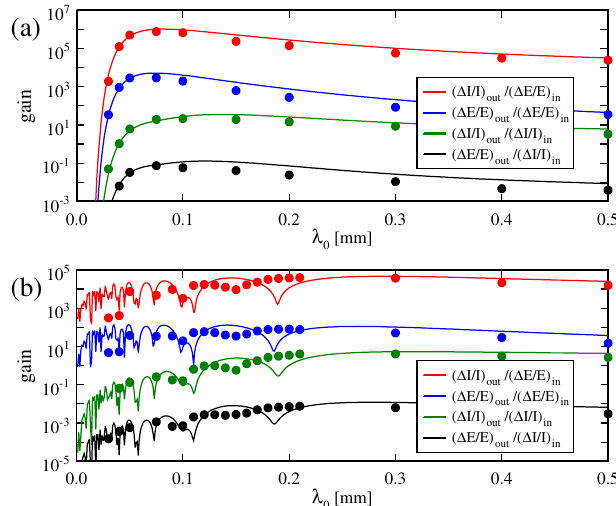
FIG. 10. (Color) Curves show the analytical microbunching gain between the entrance of the BC1 chicane at 215 MeVand the exit of the L2 linac at 1.7 GeV, for a bunch with initial current of 50 A. The gain is shown as a function of the modulation’s initial wavelength (cid:6) 0 . Plotted points show the gain in 4-million particle simulations of a 200-pC parabolic bunch with initial rms bunch length of 400 (cid:2) m and peak current of 50 A. (a) Gaussian energy distribution with initial rms energy spread of 3 keV. (b) Semicircular energy distribution from a matched laser heater, with initial rms energy spread of 10 rms Gaussian energy spread of 3 keV. The simulations were again in agreement with the formulas.